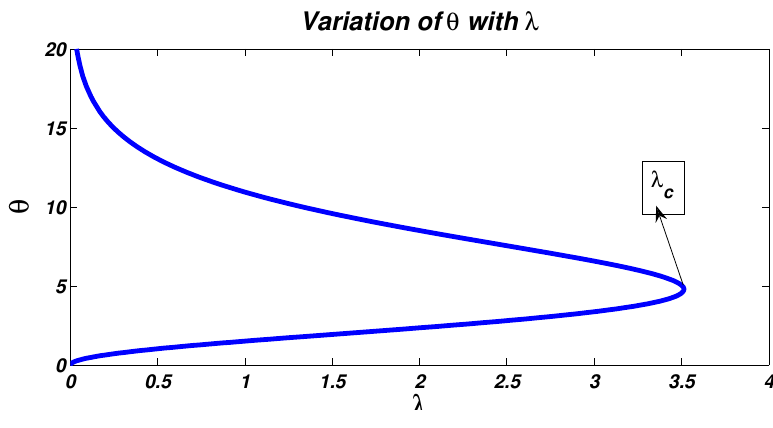
Figure 1. Variation of θ for different values of λ